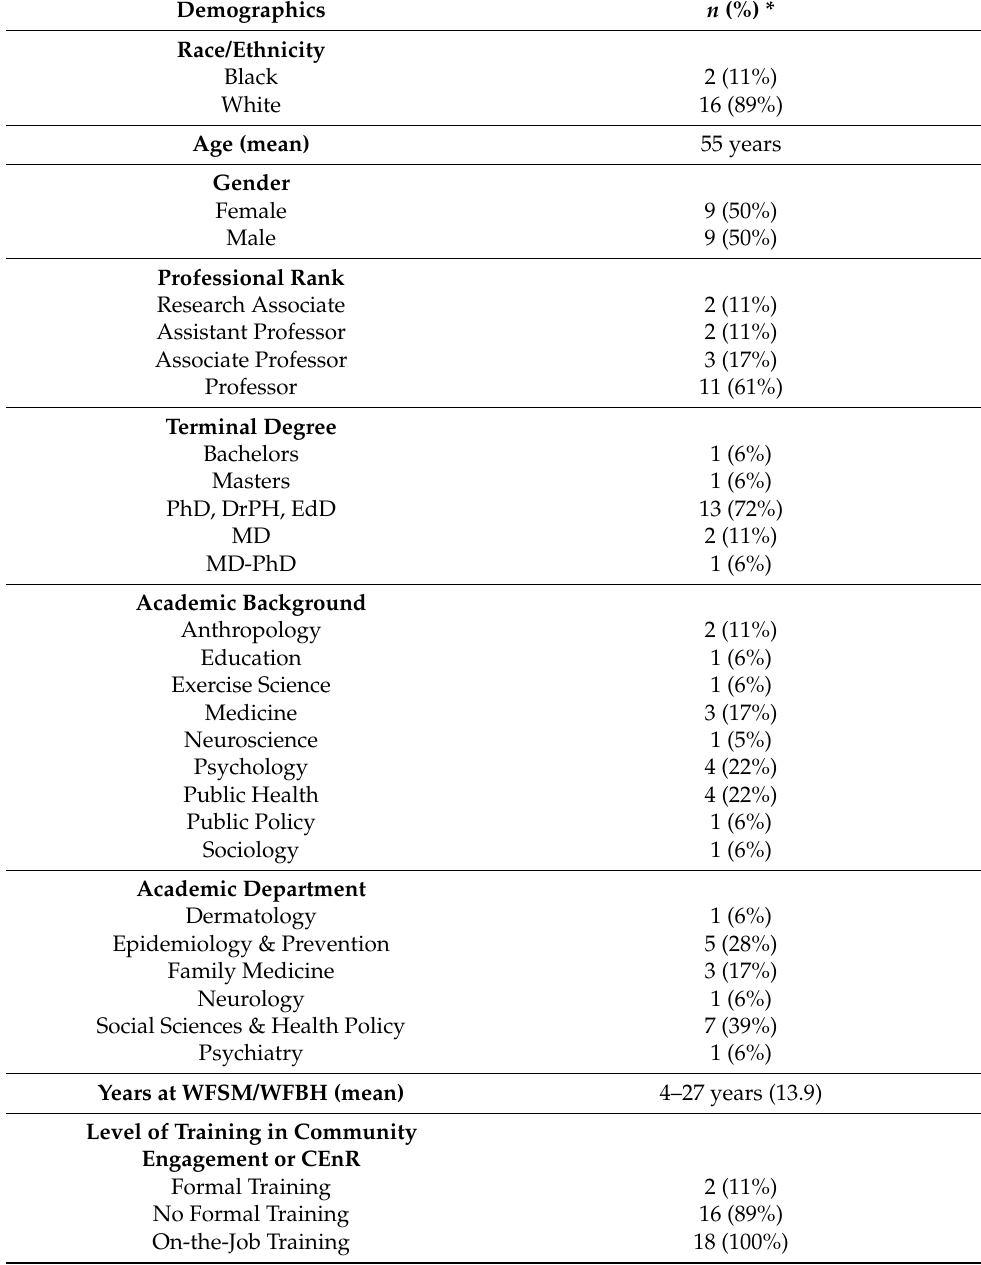
Table 2. Demographics of participants ( N =